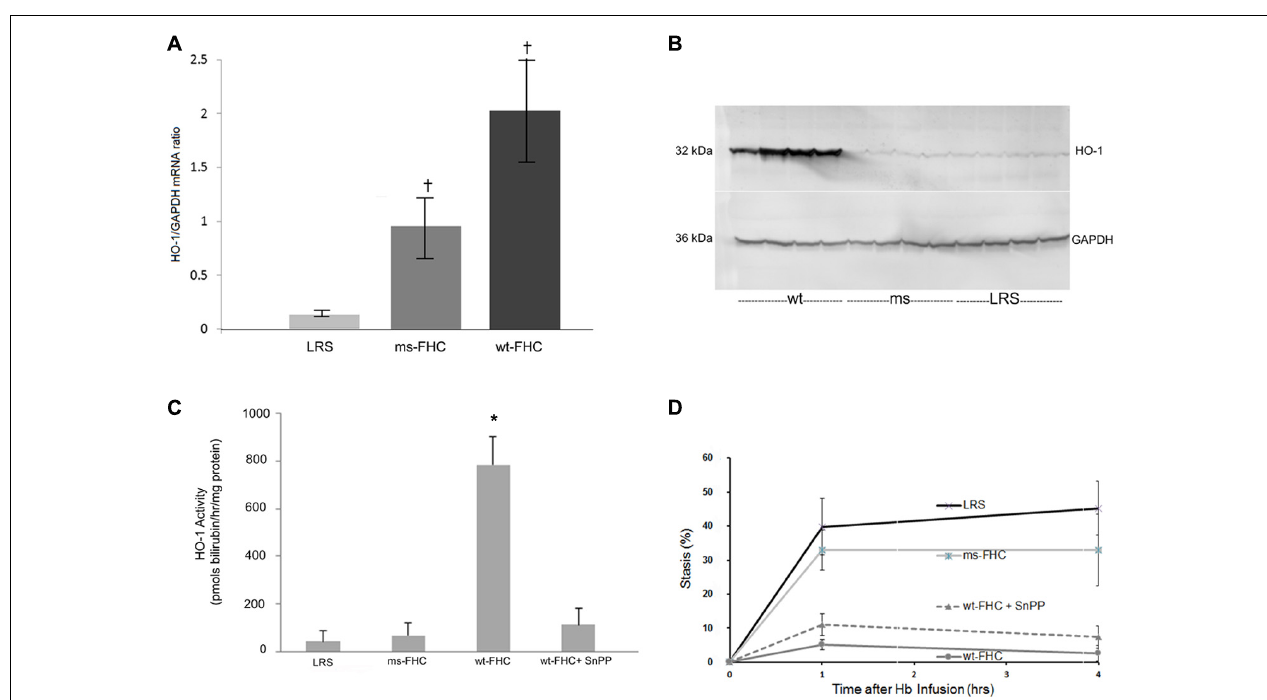
FIGURE 3 | Heme oxygenase-1 (HO-1) is up-regulated in NY1DD sickle mice expressing human wt-FHC. (A) 8 weeks after hydrodynamic infusions, liver HO-1, and GAPDH mRNA ratios were measured by qRT-PCR ( n = 4 mice per treatment group). Values are means ± SD, † p < 0.05 for wt-FHC and ms-FHC vs. LRS, as calculated by one-way ANOVA. (B) Microsomal membranes ( n = 4 mice per treatment group) were isolated from the livers, run on a western blot (30 μ g of microsomal protein per lane), and immunostained for HO-1 and GAPDH protein expression. (C) Heme oxygenase (HO) enzymatic activity was measured by measuring bilirubin production using 2 mg protein of liver microsomes per reaction ( n = 4 mice per treatment group). HO activity in